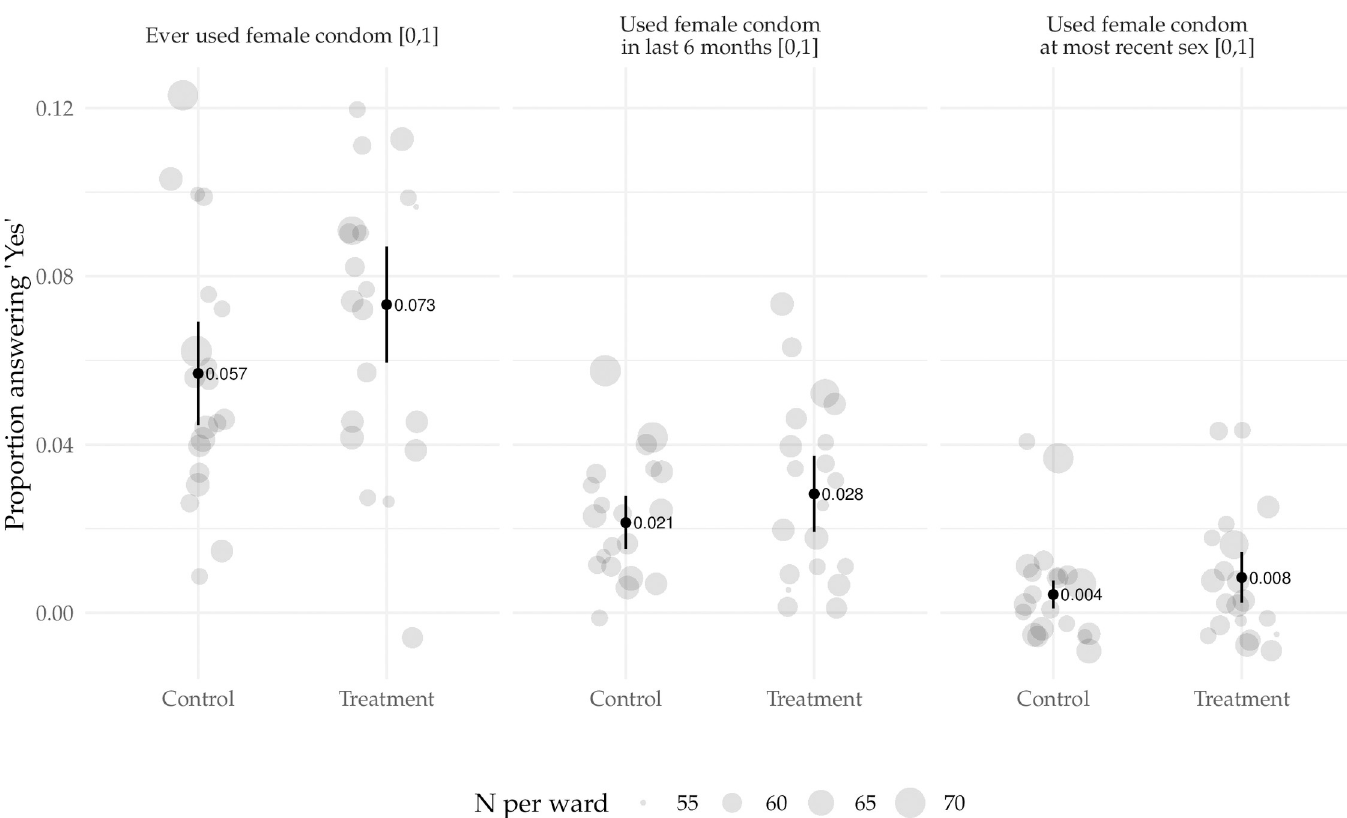
Fig 1. Proportion responding yes for the three primary outcomes (ever used a FC, used FC in last 6 months, used FC at most recent sex) per ward, comparing treatment to control arms.